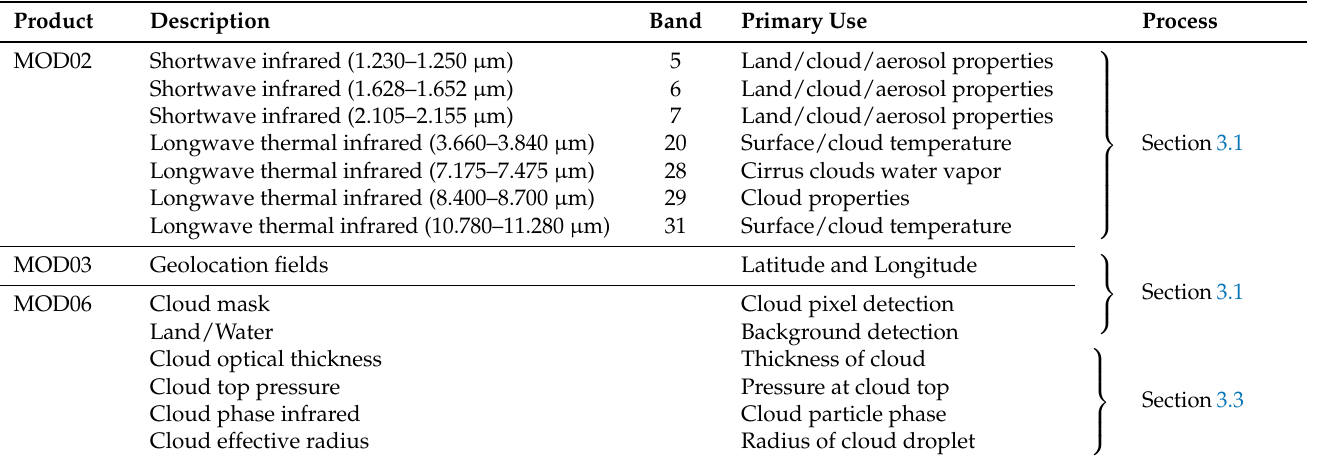
Table 1. MODIS products used to create the AICCA dataset. Each product name MOD0X in the first column refers to both the Aqua (MYD0X) and Terra (MOD0X) products. Source: NASA